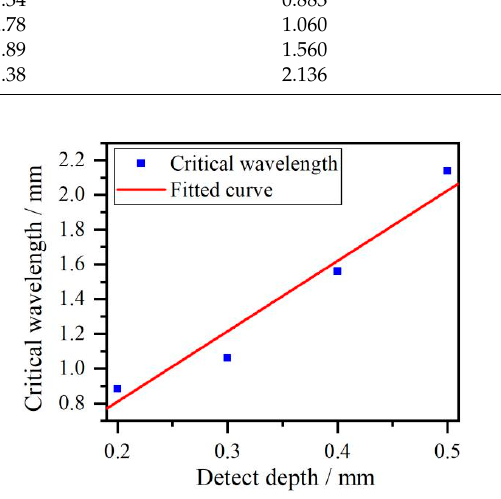
Figure 9. The critical wavelengths and cracks depth.